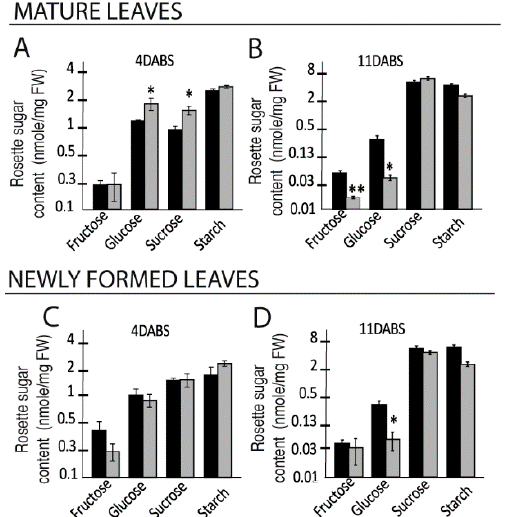
Figure 2. Variations in soluble sugars and starch content in rosette leaves in response to salt treatment. ( A – D ) Soluble sugar and starch contents in Ctrl and SStr plants, shown as bar plots drawn on a log2 scale. Contents in mature ( A , B ) and newly formed leaves ( C , D ) at 4 DABS ( A , C ), and 11 DABS ( B , D ). Values represent means ± SE ( n = 4 to 6), in control (black bar) and stress plants (grey bars). Asterisks indicate significant difference of treatments compared to control plants (* p < 0.05; ** p < 0.01).